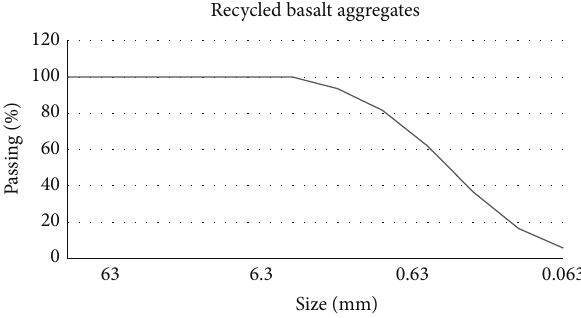
Figure 3: Basalt recycled aggregates gradation.